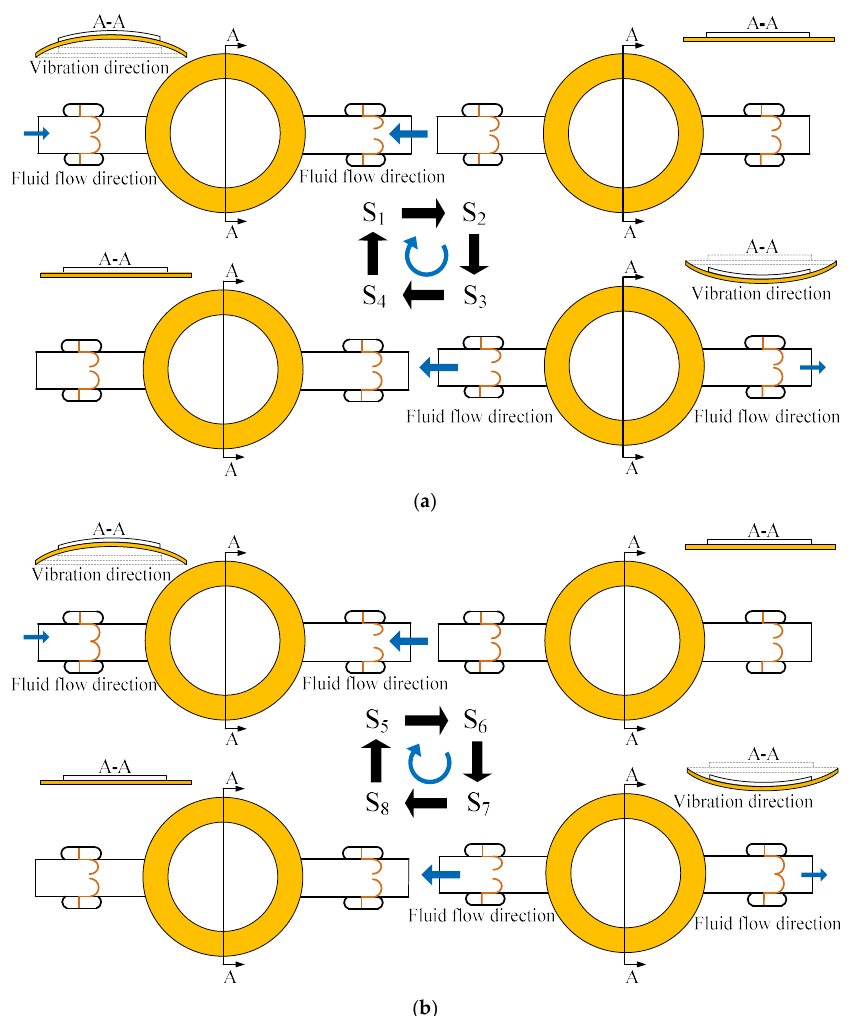
Figure 4. Working mechanisms of the piezoelectric pump with cardiac-valve-like structures: ( a ) non-valve state; ( b ) valve-based state.